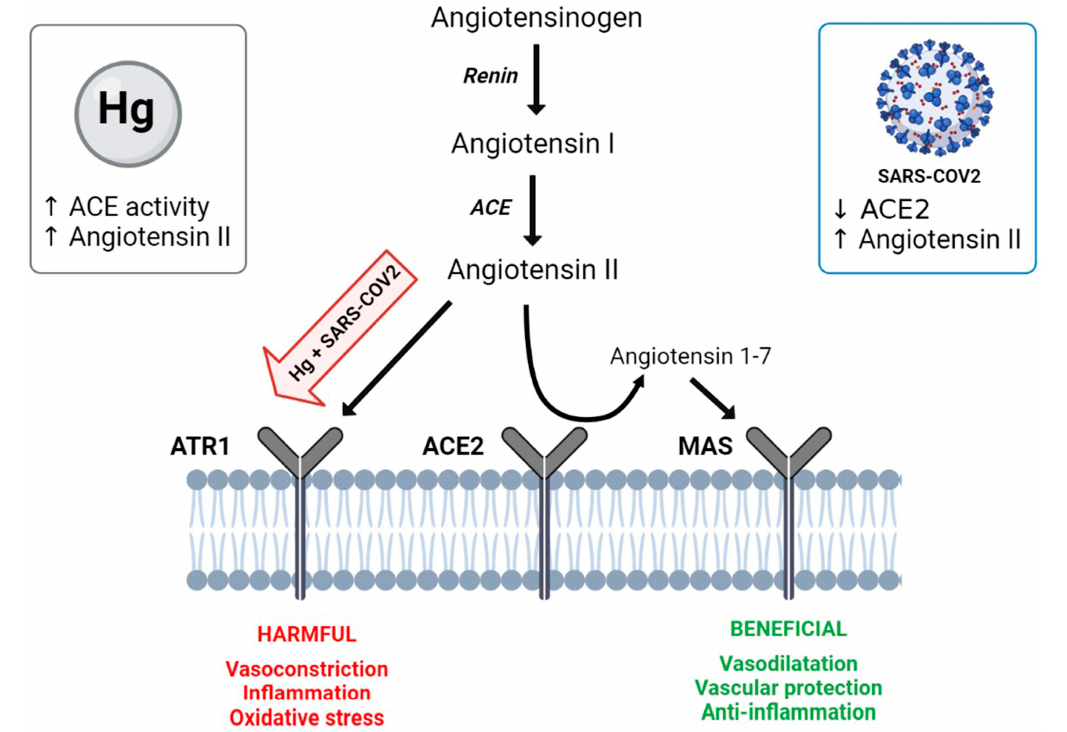
Figure 2. The renin-angiotensin system and the angiotensin-converting enzyme 2 (ACE2)/angiotensin-(1–7)/MAS axis. The angiotensinogen is converted to angiotensin I by renin; then, angiotensin-converting enzyme (ACE) converts angiotensin I to angiotensin II. The binding of angiotensin II to the angiotensin type 1 receptor (AT1R) causes harmful actions, such as vasoconstriction, inflammation and oxidative stress. Angiotensin II can be converted to angiotensin-(1–7) by ACE2. Angiotensin-(1–7) can bind to the MAS receptor to exert benefic actions such as vasodilation, vascular protection and anti-inflammation. SARS-CoV-2 enters cells via ACE2 and, together with the coronavirus, the intact ACE2. Mercury (Hg) intoxication increases the plasma ACE activity. Both insults lead to high plasma levels of angiotensin II. Could SARS-CoV-2 and mercury act synergically to potentiate the harmful effects displayed by angiotensin II? Created with BioRender.com accessed on 6 February